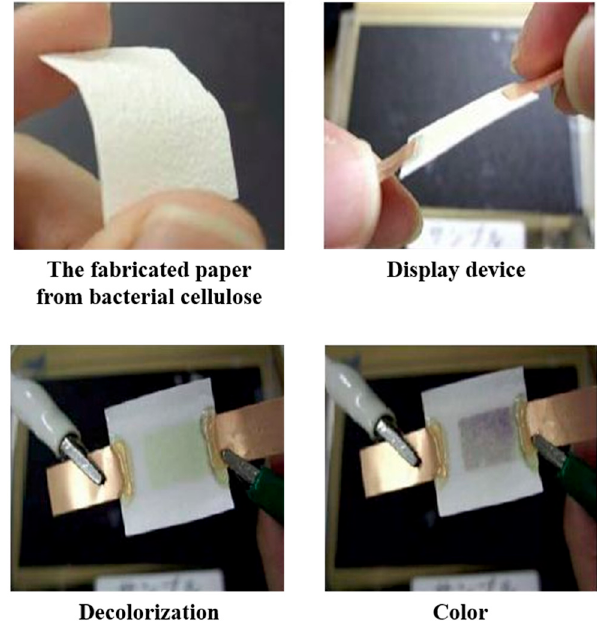
Figure 16. Electrodes directly on paper made from BC [203].